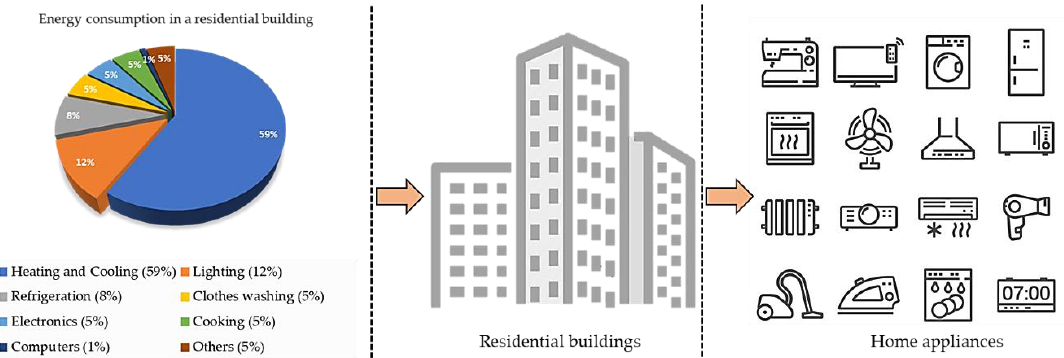
Figure 1. Massive amount of energy is consumed in the residential sector because various electrical appliances are installed.